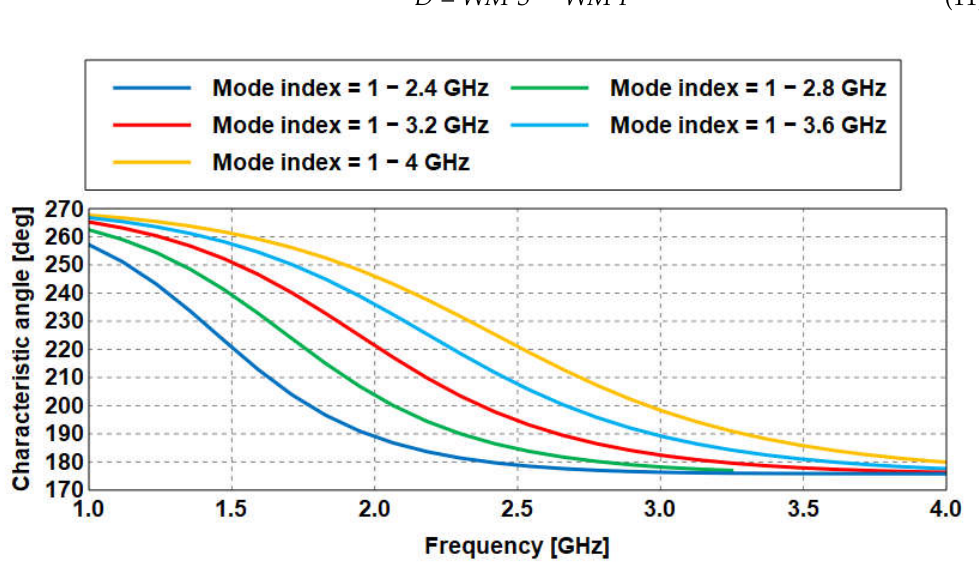
Figure 3. Characteristic angle of a square patch at different operating frequencies.